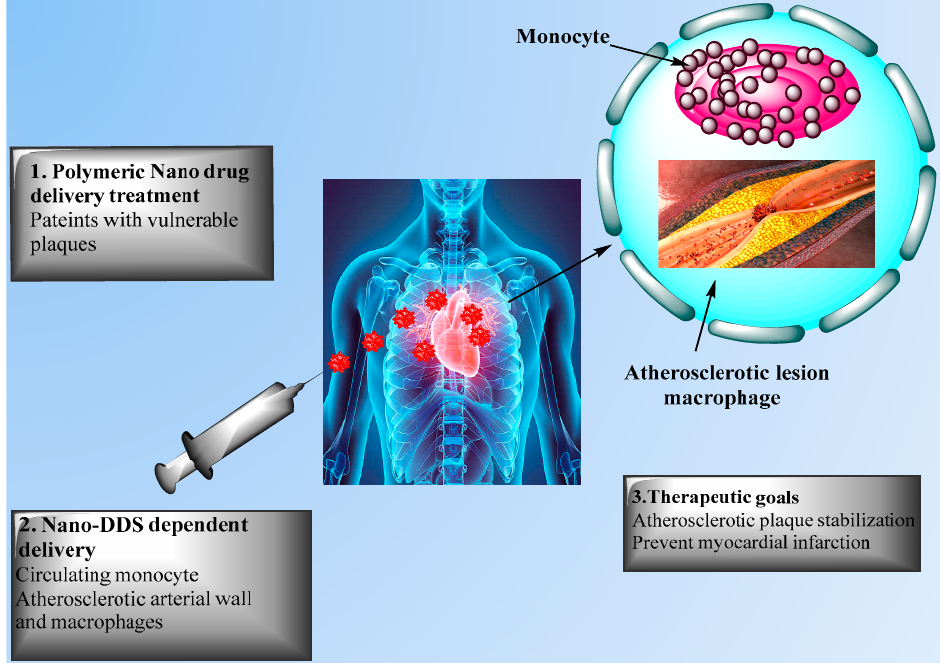
Figure 6. Nanodrug delivery systems for the treatment of acute coronary syndrome. The Figure presents nanodrug delivery system (Nano-DDS)-mediated treatments for patients with unstable plaque via (1) intravenous injection and (2) delivery to circulating monocytes, with (3) therapeutic goals including atherosclerotic plaque stabilization and prevention of acute myocardial infarction.